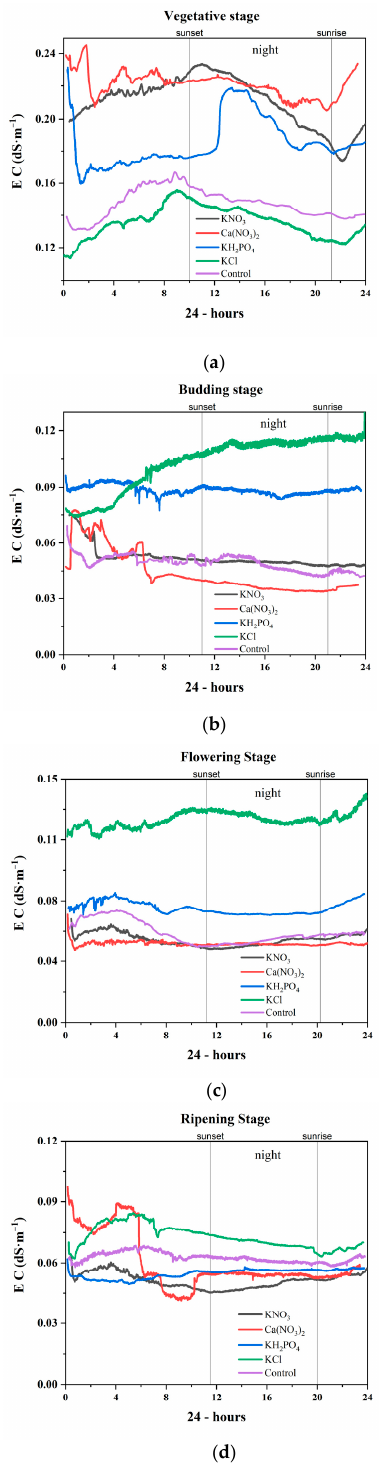
Figure 2. The electrical conductivities of different macronutrient treatments measured in vegetative ( a ), budding ( b ), flowering ( c ) and ripening stages ( d ). The 24 h electrical conductivities (ECs) were recorded from the first day, at 9.30 a.m. till the next day at 9.30 a.m. The vertical lines mark the sunset and sunrise.